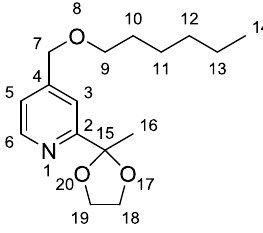
Figure 1. Structure and atom numbering of Intermediate Compound 2 .